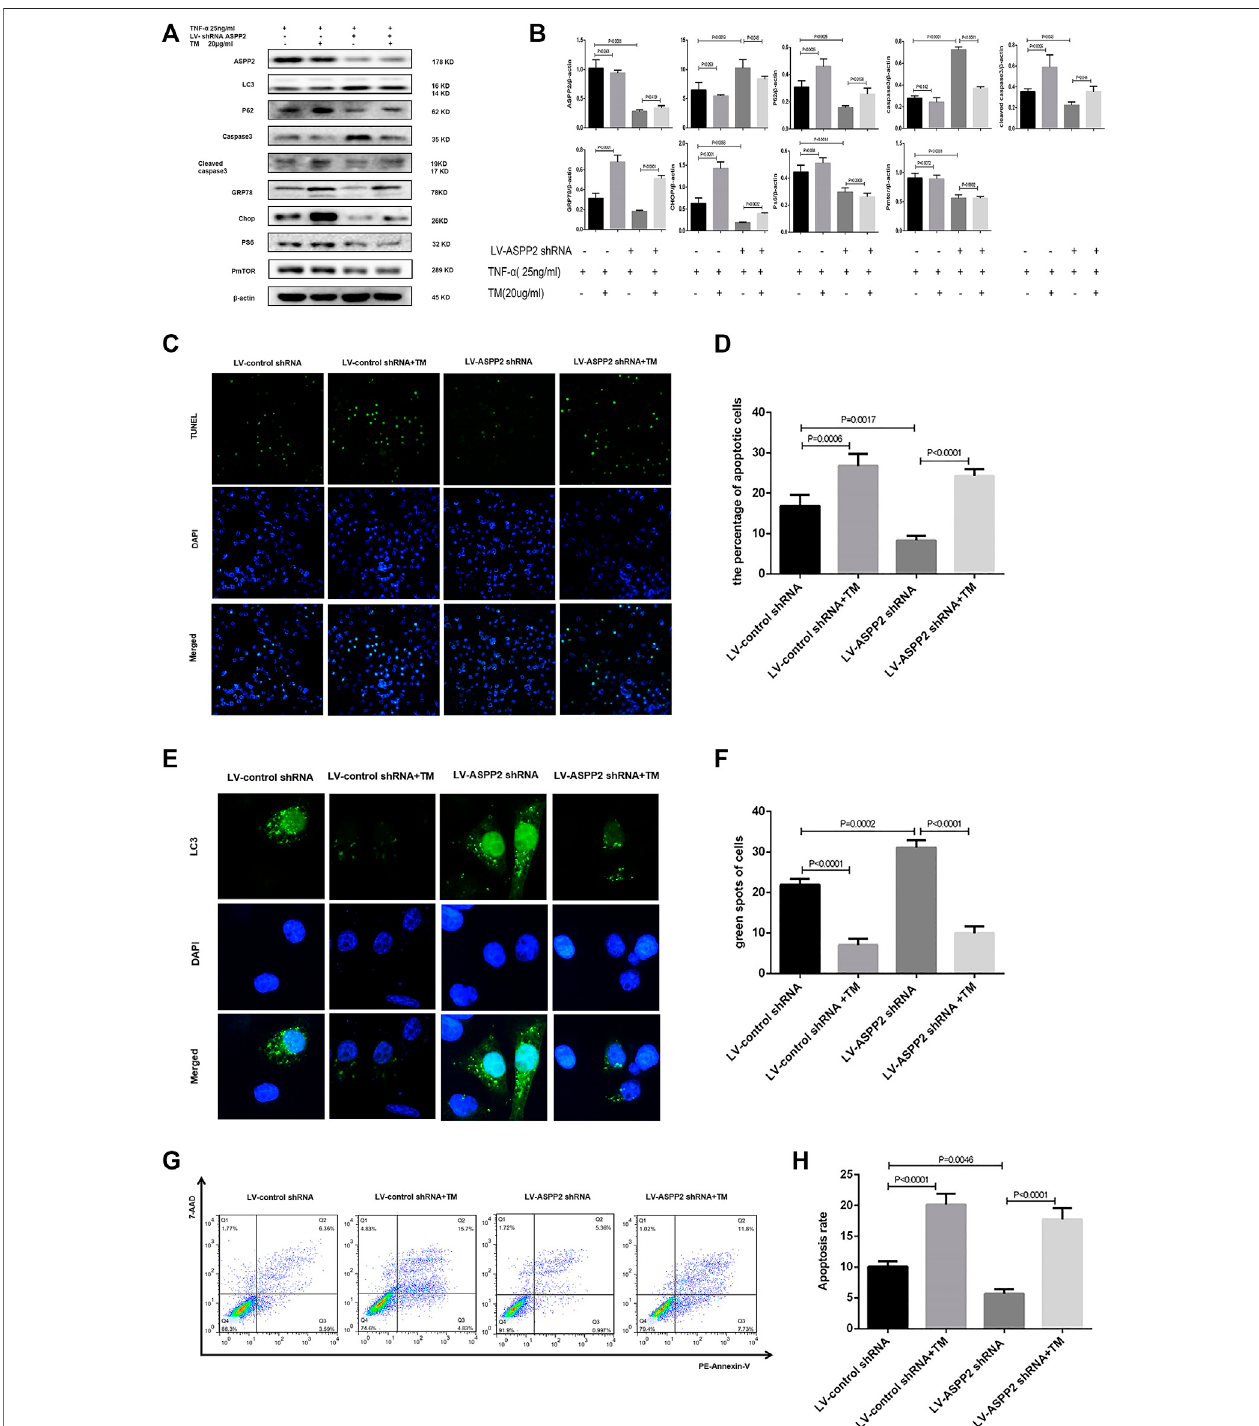
FIGURE 4 | ERS promoted ASPP2 mediated-apoptosis, but suppressed autophagic fl ux in case of hepatocyte injury induce by TNF- α . HL7702 cells were integratedintostable celllines usingLV-ASPP2shRNA orLV-controlshRNA. Thestable celllines weretreatedwithTM(20 ng/ml)and theninducedbyTNF- α (25 ng/ml) for24 h. (A,B) Representativewesternblottinganalysiswasconducted ofprotein expression inHL7702cellsaftertreatment.Quanti fi cations werenormalized to β -actin and expressed as relative density. (C,D) Representative apoptosis images were presented by TUNEL assay. The number of apoptotic cells were counted by ImageJ software. (E,F) A GFP-LC3 plasmid was transfected into cells and the representative fl uorescence image of cells was showed. The green spots of cells were manuallyquanti fi edin fi verandomlyselectedareas. (G,H) RepresentativeapoptosisimageswereshowedwithPEand7-AADreagentsby fl owcytometry.Theapoptosis rate was calculated using the proportion of early and late apoptotic cells in total cells.